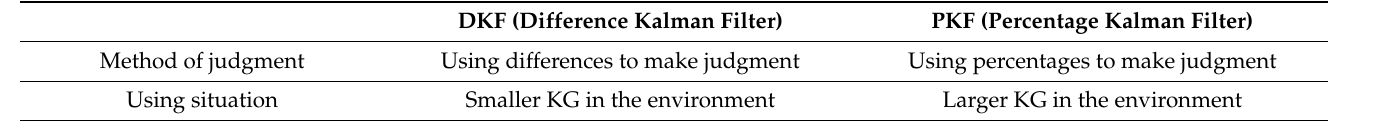
Table 1. The difference between DKF and PKF. DKF (Difference Kalman Filter) PKF (Percentage Kalman Filter) Method of judgment Using differences to make judgment Using percentages to make judgment Using situation Smaller KG in the environment Larger KG in the